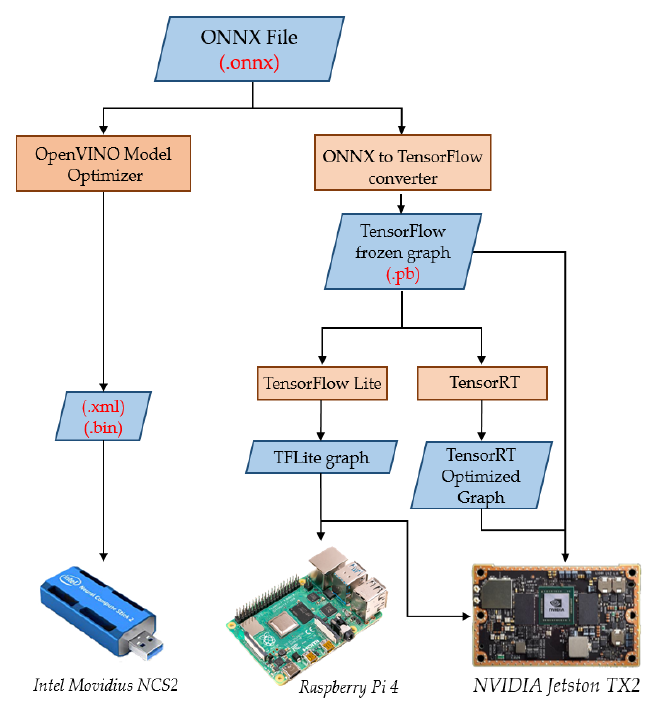
Figure 8. Implementation